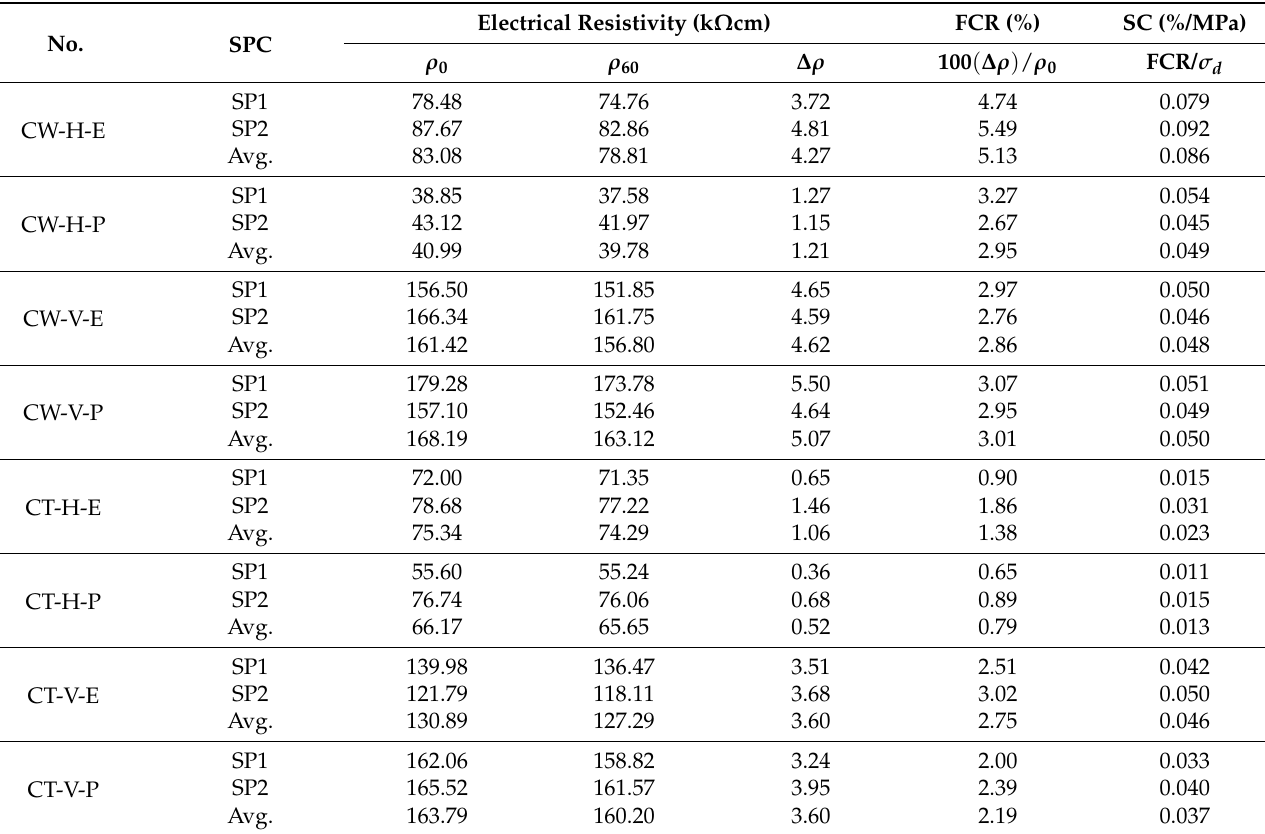
Table 6. Electromechanical parameters of the SCA under compressive